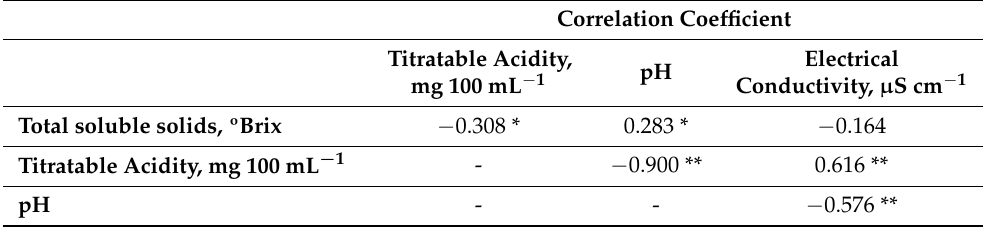
Table 1. Correlation analysis data between components in the sap and acidity values.